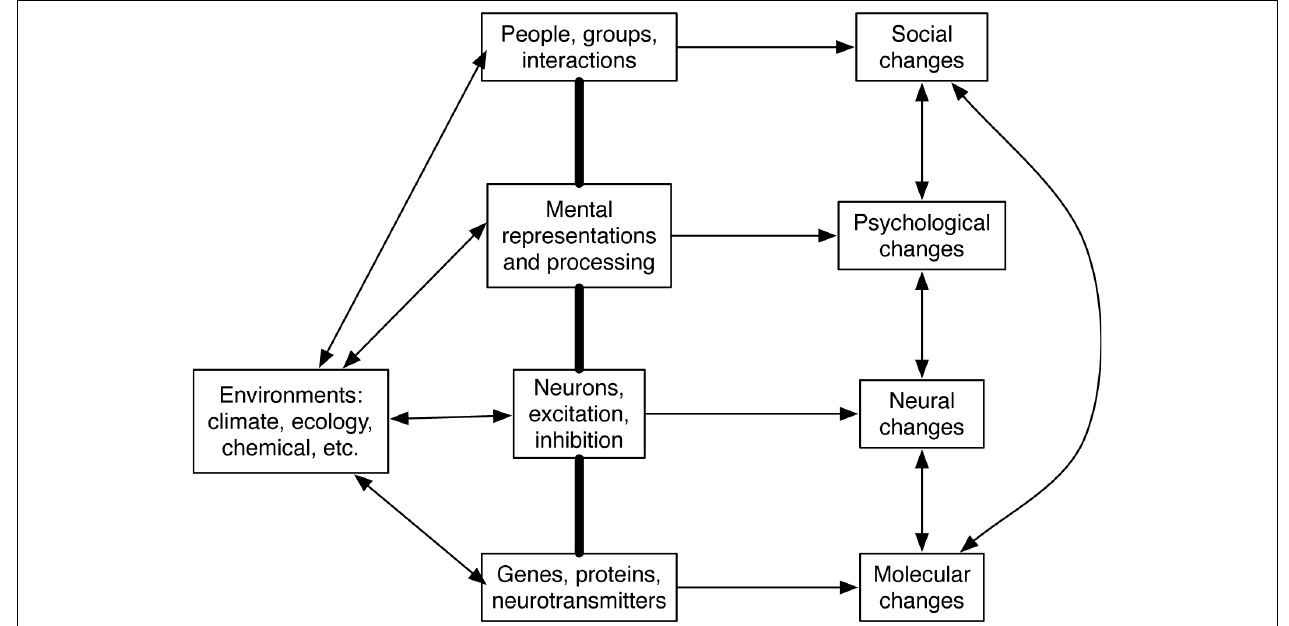
FIGURE 2 | Diagram of the self as a multilevel system. Lines with arrows indicate causality. Thick lines indicate composition. Source: Thagard (2014).